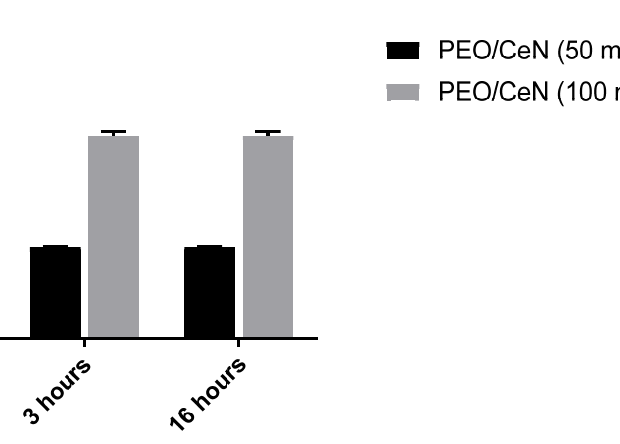
Figure 5. % Cumulative Ce(III) released per scaffold (µg/mg) over 16 h for 50 mg scaffold /mL diluent and 200 mg scaffold /mL diluent PEO/Ce(III) (n = 9).